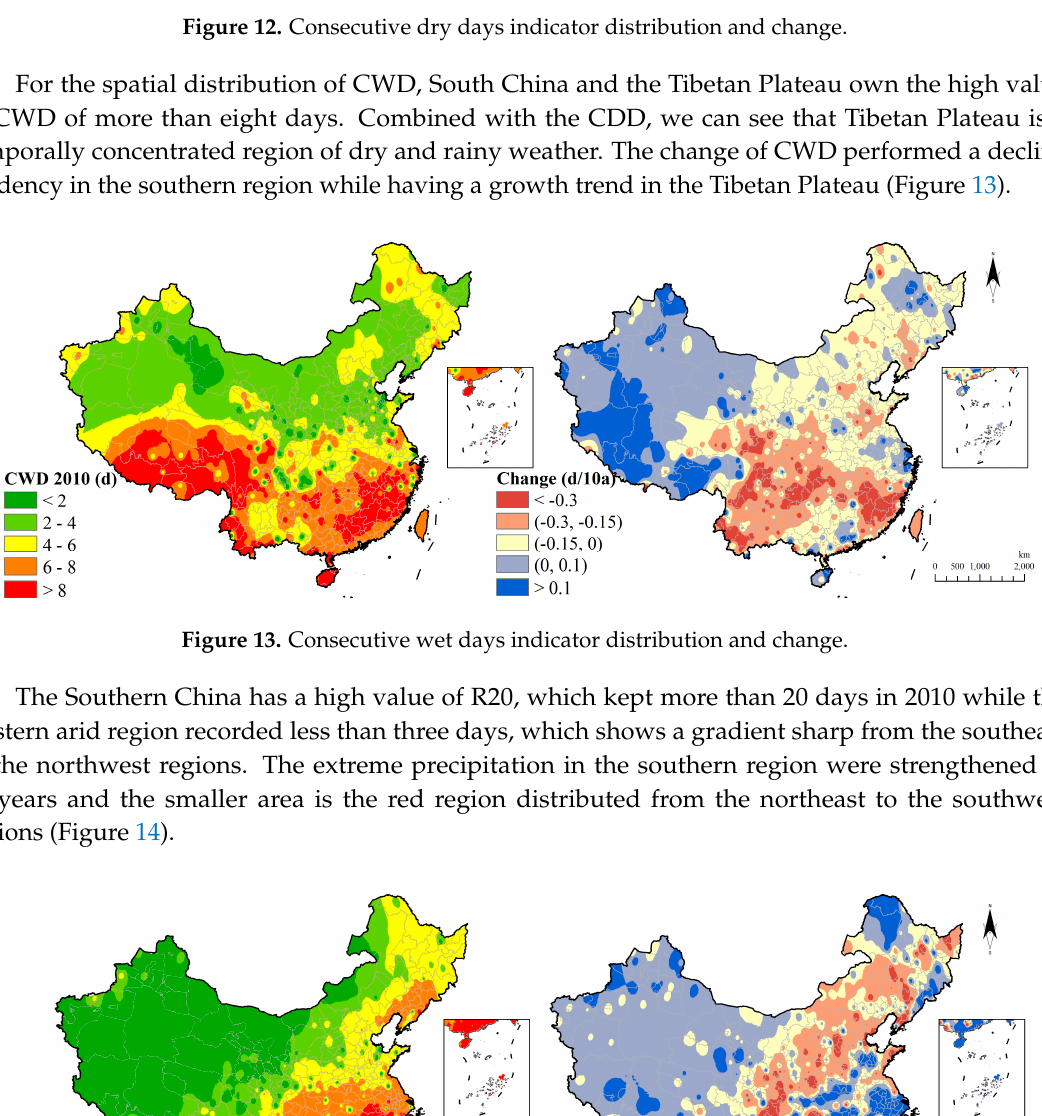
Figure 15. Very wet days indicator distribution and change.